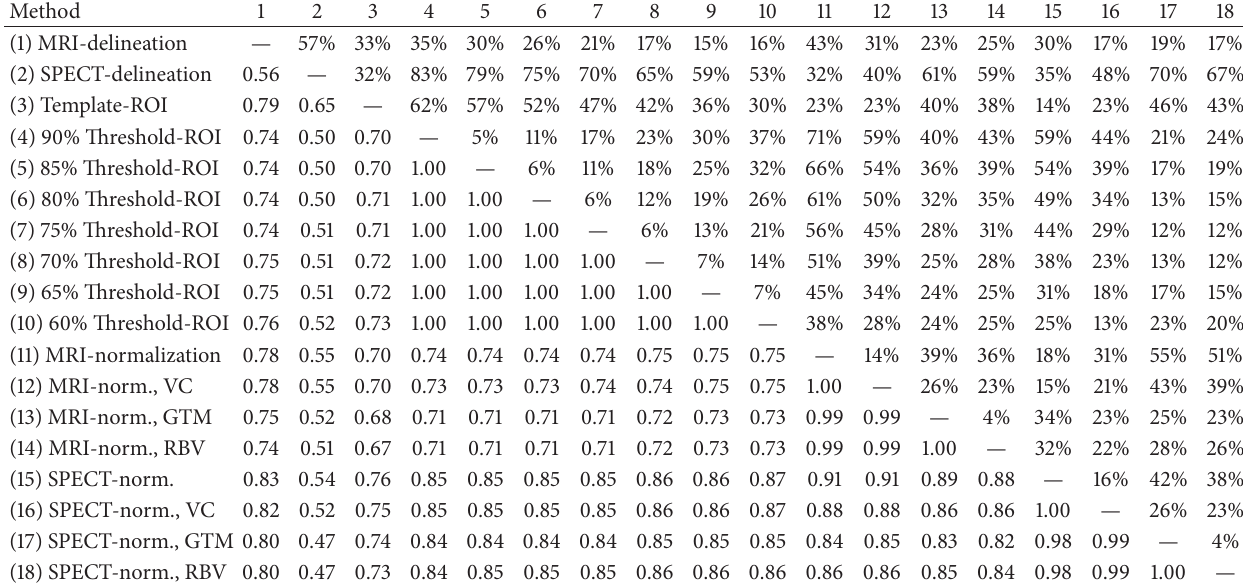
Table 1: Pearson product-moment correlation coefficients (bottom left) and ratios of the root-mean-square differences to the averages (top right) between quantification methods of measuring DAT availabilities.